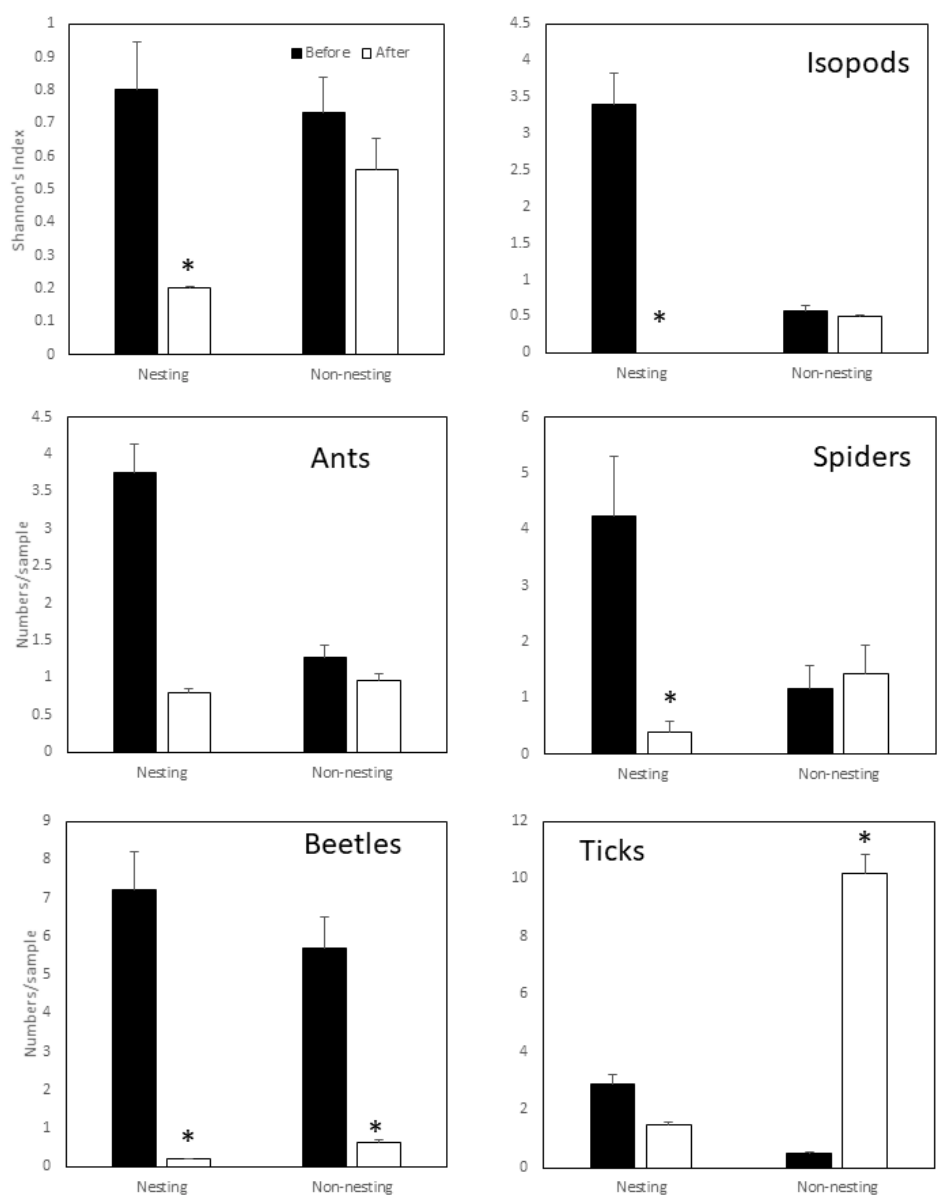
Figure 2. Comparison of the Shannon’s Index values and abundance (numbers per sample) of selected taxa in nesting and non-nesting areas both before and after nesting periods of Socotra Cormorants. Error bars indicate standard error. Standard error for Shannon’s Index values were calculated using randomization methods (9999 replications) with replacement. * represents differences that are significant at α =0.05.